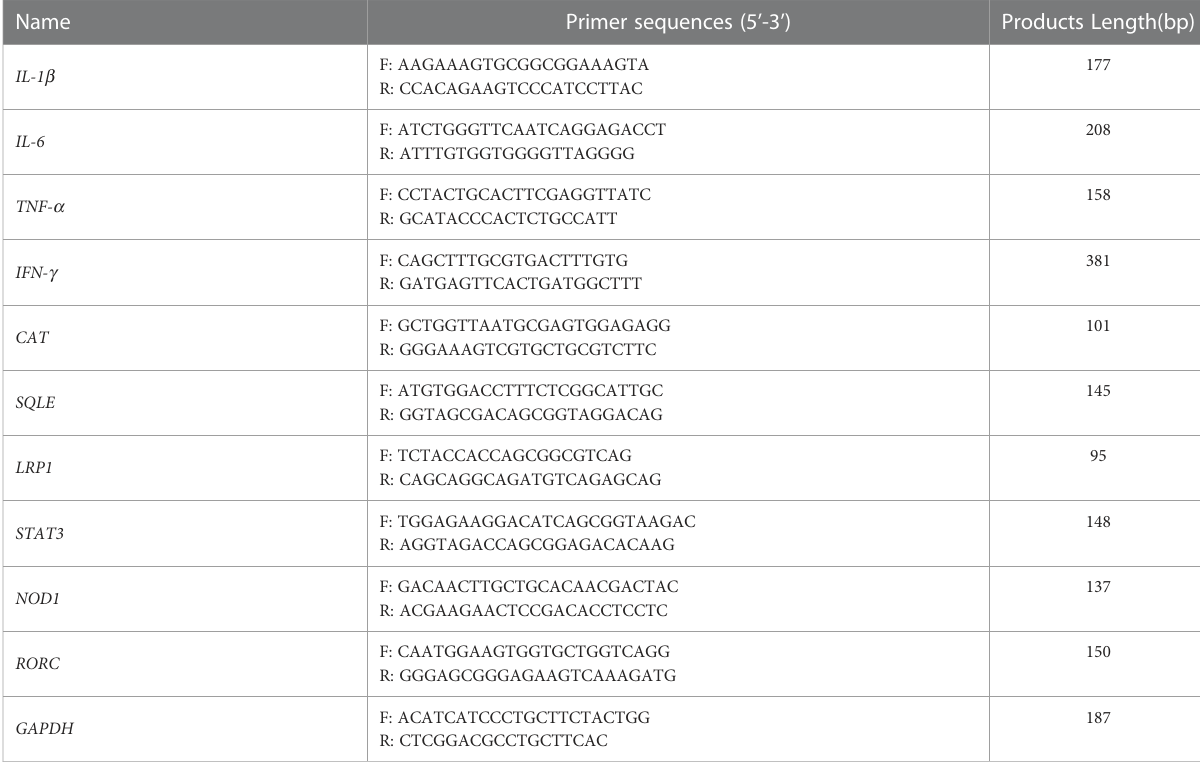
TABLE 1 Real-time PCR primer